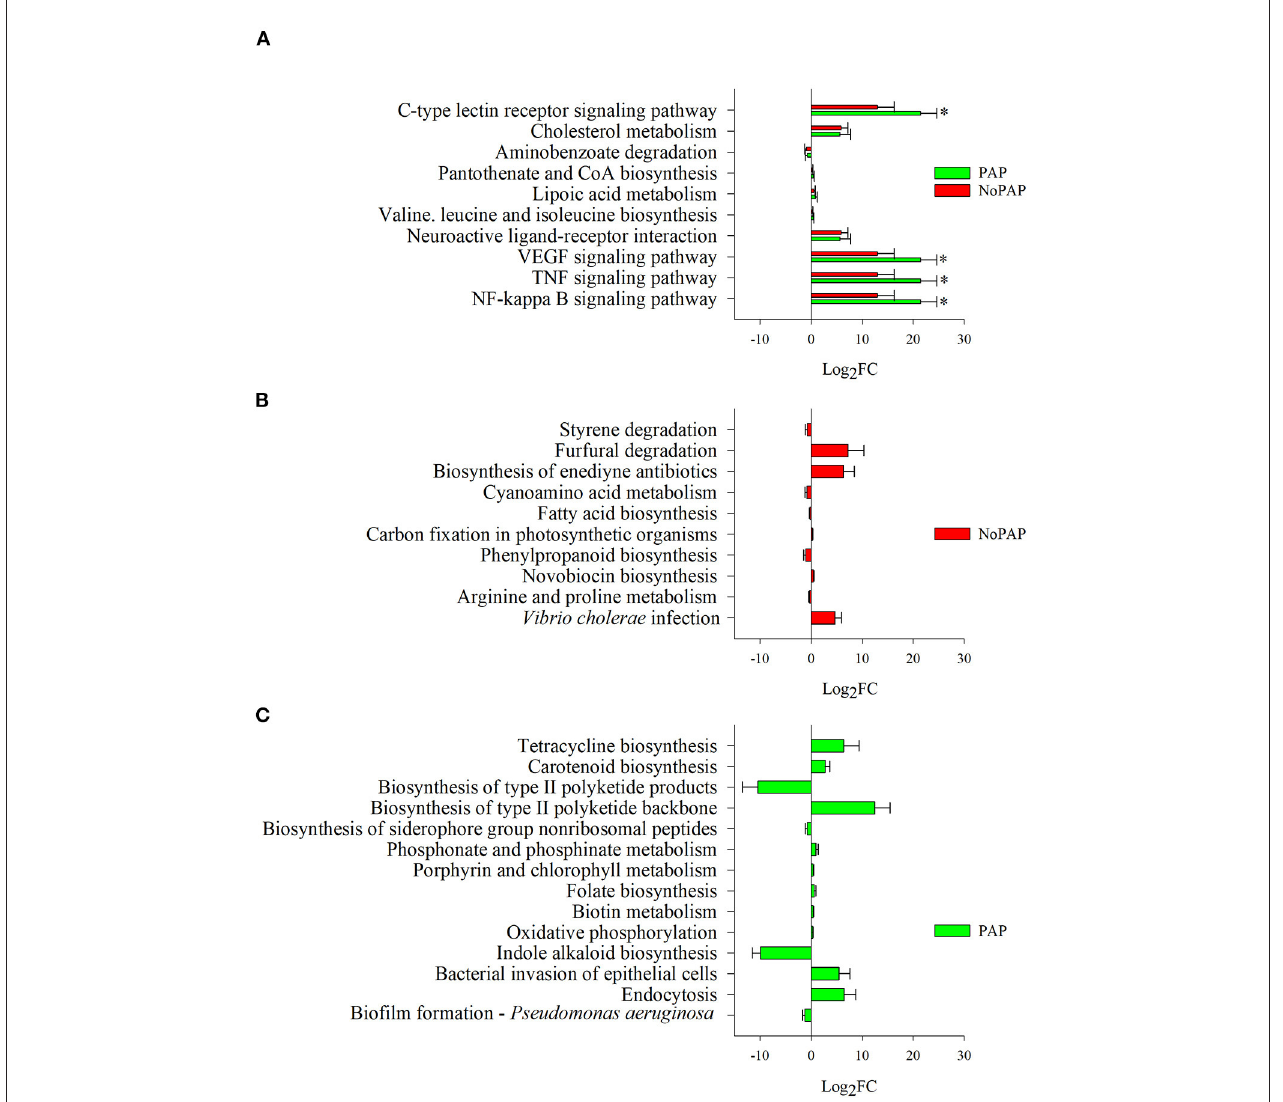
FIGURE 4 | Results from the pathway analysis performed with the predicted metagenome obtained from the discriminant OTUs with VIP ≥ 1. (A) Differentially and common represented pathways (padj < 0.05) when comparing the PAP or non-PAP diets with the CTRL diet. The asterisk represents the result of a differential pathway representation (padj < 0.05) between the NoPAP and PAP diets. (B) Exclusively differentially represented pathways in the non-PAP vs. CTRL comparison. (C) Exclusively differentially represented pathways in the PAP vs. CTRL comparison. Bars show the Log 2 fold change of differentially over- or under-represented pathways ( ± standard error of the calculated fold